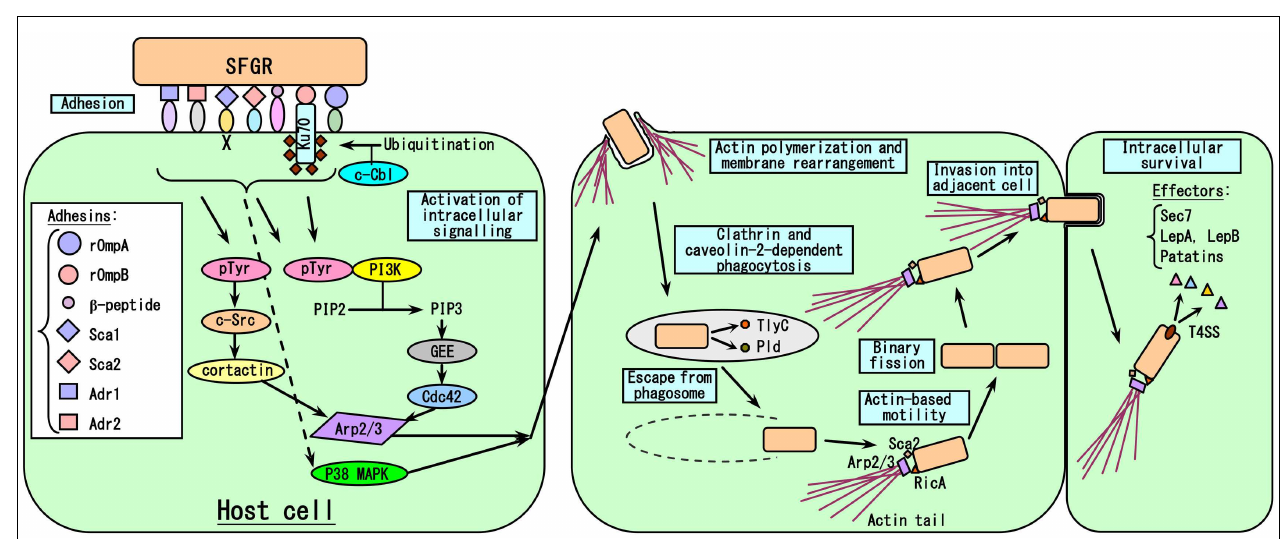
and Pld. In the case of SFGR, the surface molecules RicA and Sca2 recruit Arp2/3 to polymerize actin, resulting in the formation of an actin tail, which aids the movement of the bacteria. However, in the case ofTGR, R. prowazekii does not have an actin tail, while R. typhi has a very short actin tail. SFGR invade the adjacent cells very early in the course of the infection. Rickettsiae grow within cells by binary fission.TheVirB-related T4SS is essential for the intracellular survival of rickettsiae as it allows them to secrete effector